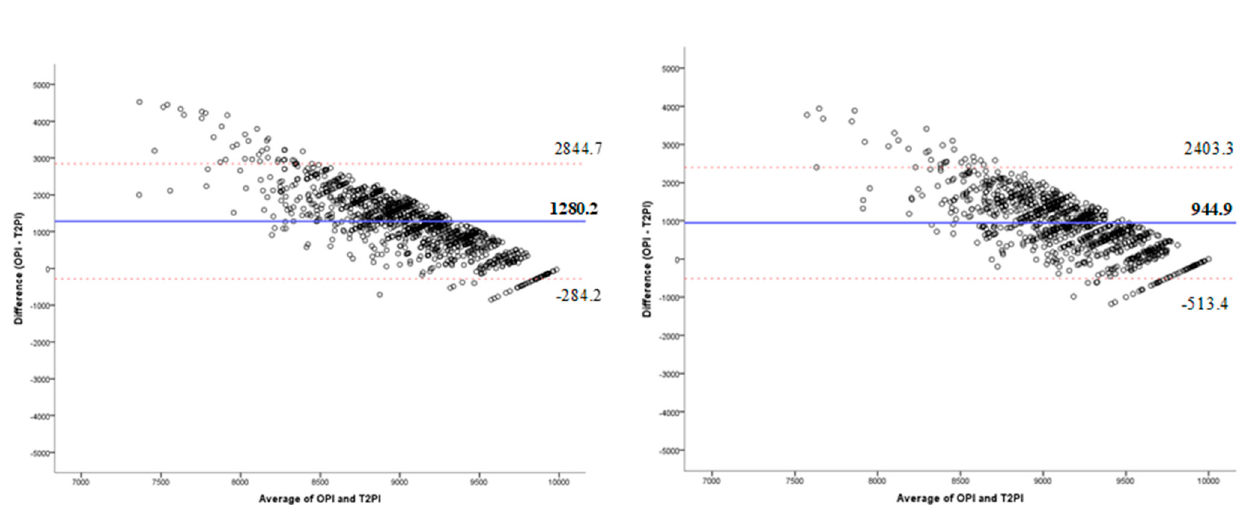
Figure 2. Bland-Altman plots showing differences in performance according to the transition 1 performance indicator (T1PI), transition 2 performance indicator (T2PI) and overall performance indicator (OPI). The red lines represent the upper and lower 95% limits of agreement, whereas the blue line represents the bias.